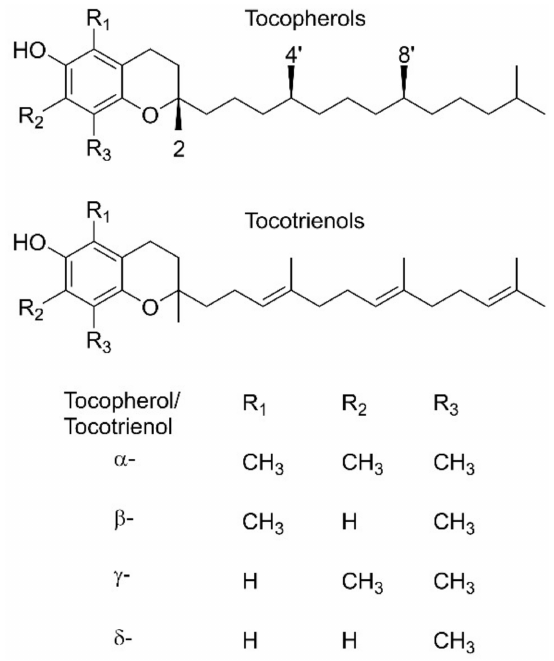
Scheme 1. Structures of vitamin E